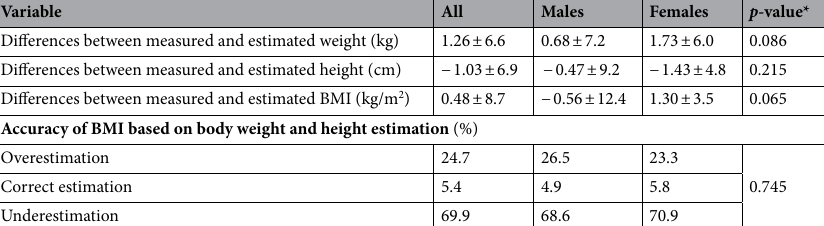
Table 2. Differences between measured and reported body weight, height and corresponding calculated BMI. * T-test for independent samples or Chi Squares tests for the